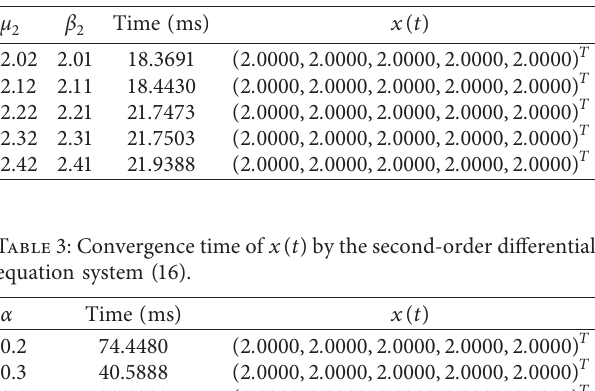
Table 2: Convergence time of x ( t ) by the second-order differential equation system (16).